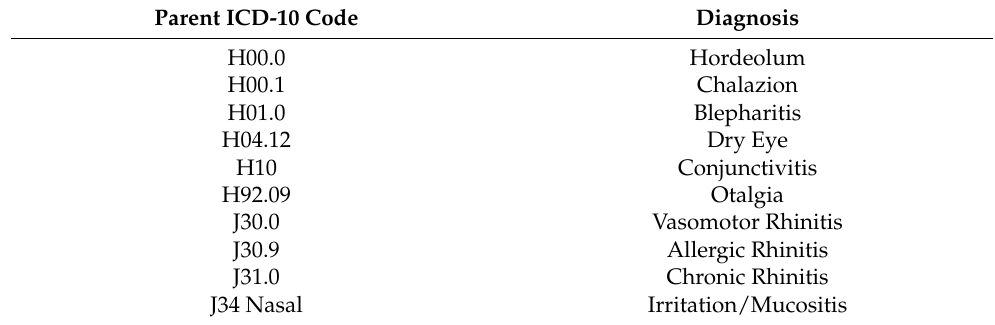
Table 1. List of ICD-10 codes